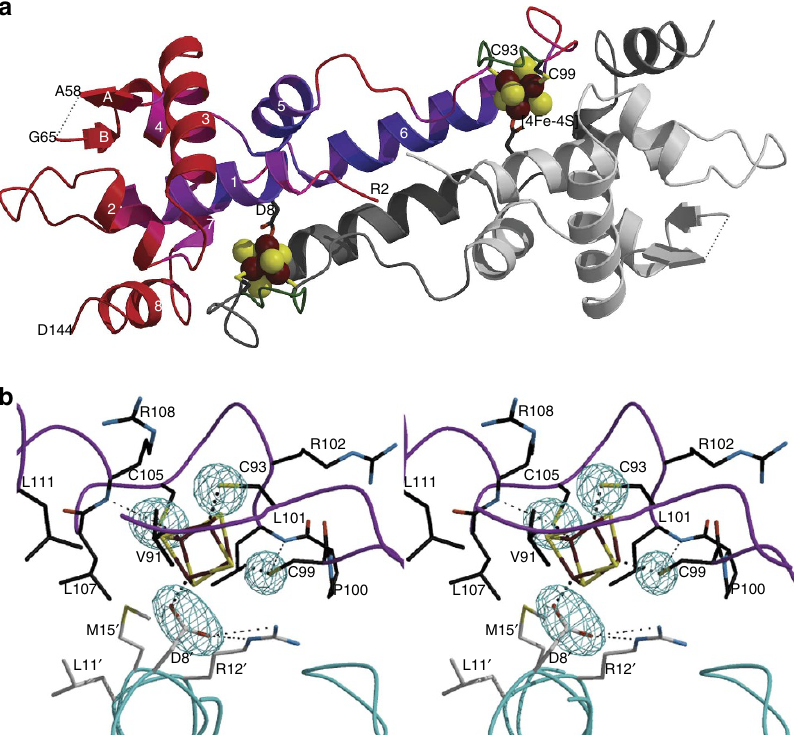
Figure 2 | Structure of holo ScNsrR. ( a ) Ribbon depiction of the functional dimer. One monomer is coloured from blue to red according to increasing temperature factors (from 56.5 to 97.4Å 2 ) and the other monomer has its two domains depicted in light and dark shades of grey (see Methods section). Secondary structure elements are labelled 1–8 for a -helices and A–B for b -strands. Fe and S atoms are shown as brown and yellow spheres, respectively. The functionally important C93–C99 loop (see text) is coloured green. ( b ) Stereo view of the [4Fe–4S] cluster environment with omit electron density peaks (blue mesh, contoured at six times the r.m.s. s level of the map) corresponding to the S g and carboxylate ligands. The main chains of the two monomers are depicted in pink and blue, respectively; Fe-ligand and H-bonding interactions are indicated with thick dotted and thin dashed lines, respectively. Atom colours are: O red, N blue and C black or